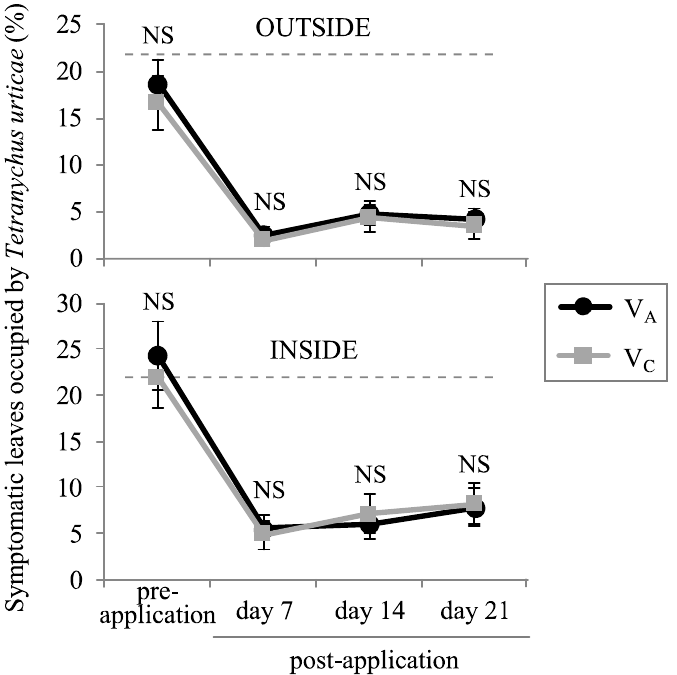
Figure 6. Symptomatic leaves occupied by Tetranychus urticae (%, mean ± standard error) at two depths of the canopy (outside, inside) and per treatment (V A : adjusted volume; V C : conventional volume). The dotted line indicates the treatment threshold: 22% of symptomatic leaves occupied. NS stands for not statistically significant (LSD test, p < 0.05).